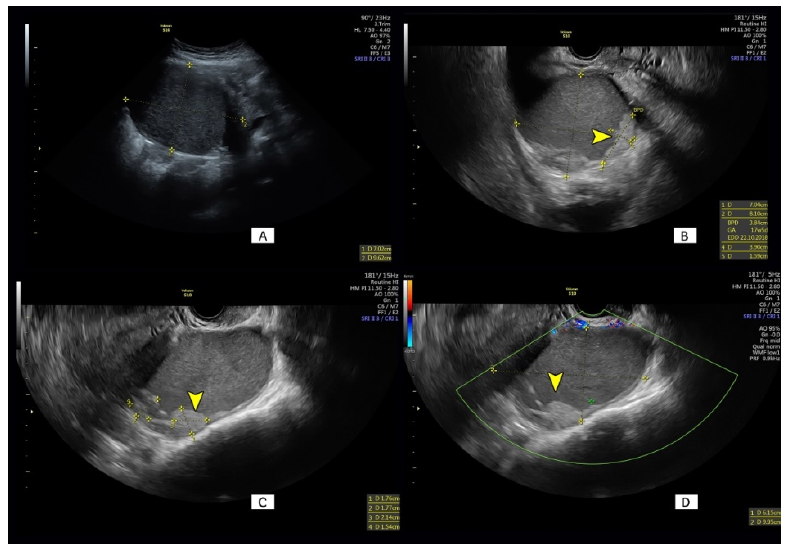
Figure 4. Sonographic images of an ovarian cystic–solid lesion of 96mm maximum diameter detected at 12 weeks of gestation and thought to be ovarian decidualized endometrioma ( A ). Smooth-shaped internal cyst wall papillary projections (arrowheads, B and C ), with no vascularity seen at color Doppler imaging (green border window, arrowhead, D ). Final histological diagnosis was invasive endometrioid ovarian cancer.